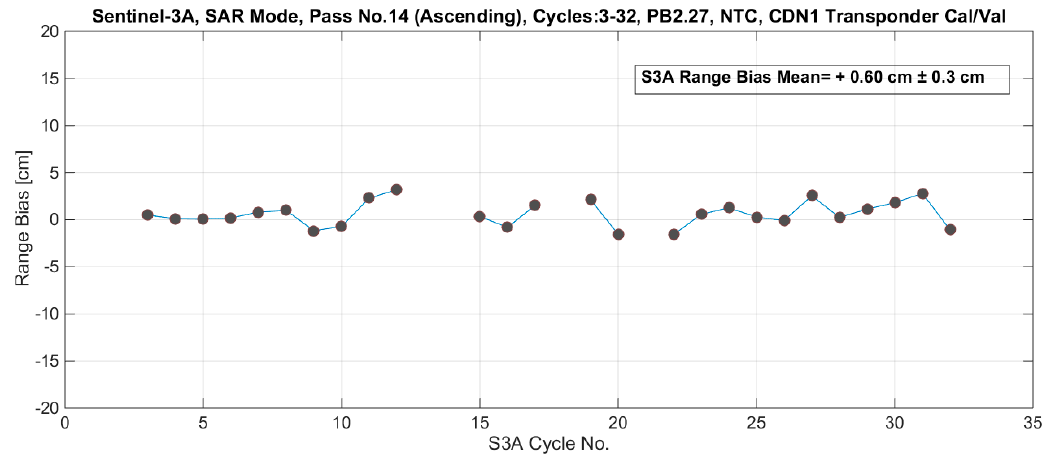
Figure 18. An example of data processing and procedures, in a Block diagram, to arrive at the transponder absolute coordinates and their uncertainties.